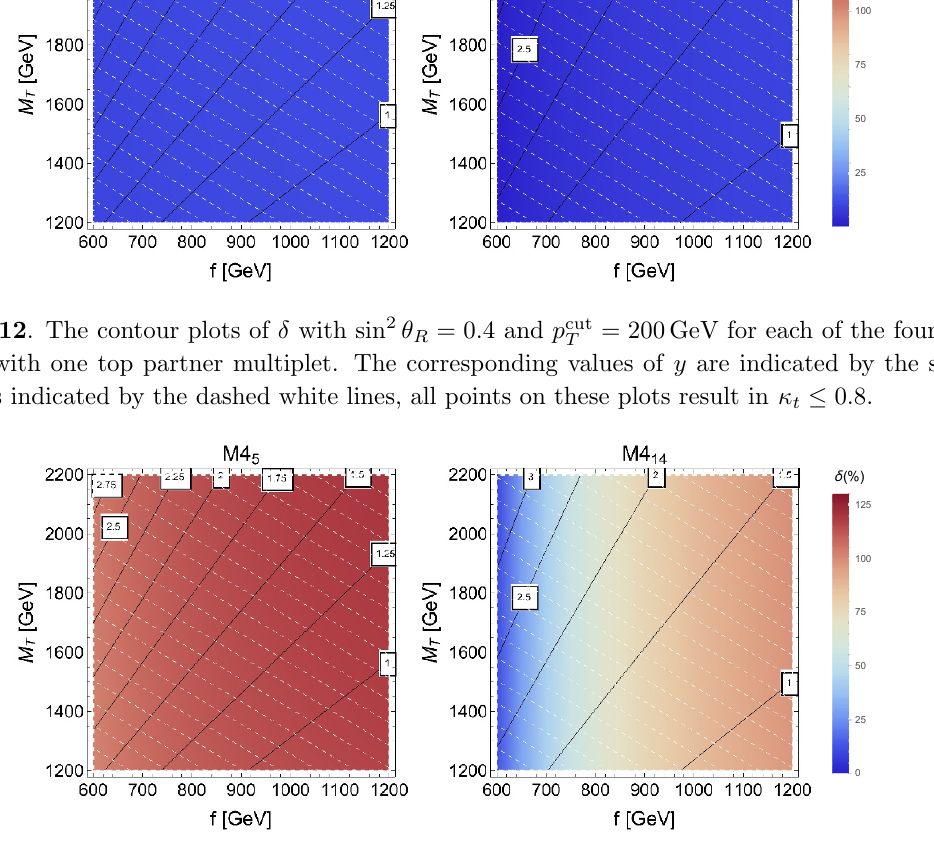
= 600 GeV for each of the fourplet T